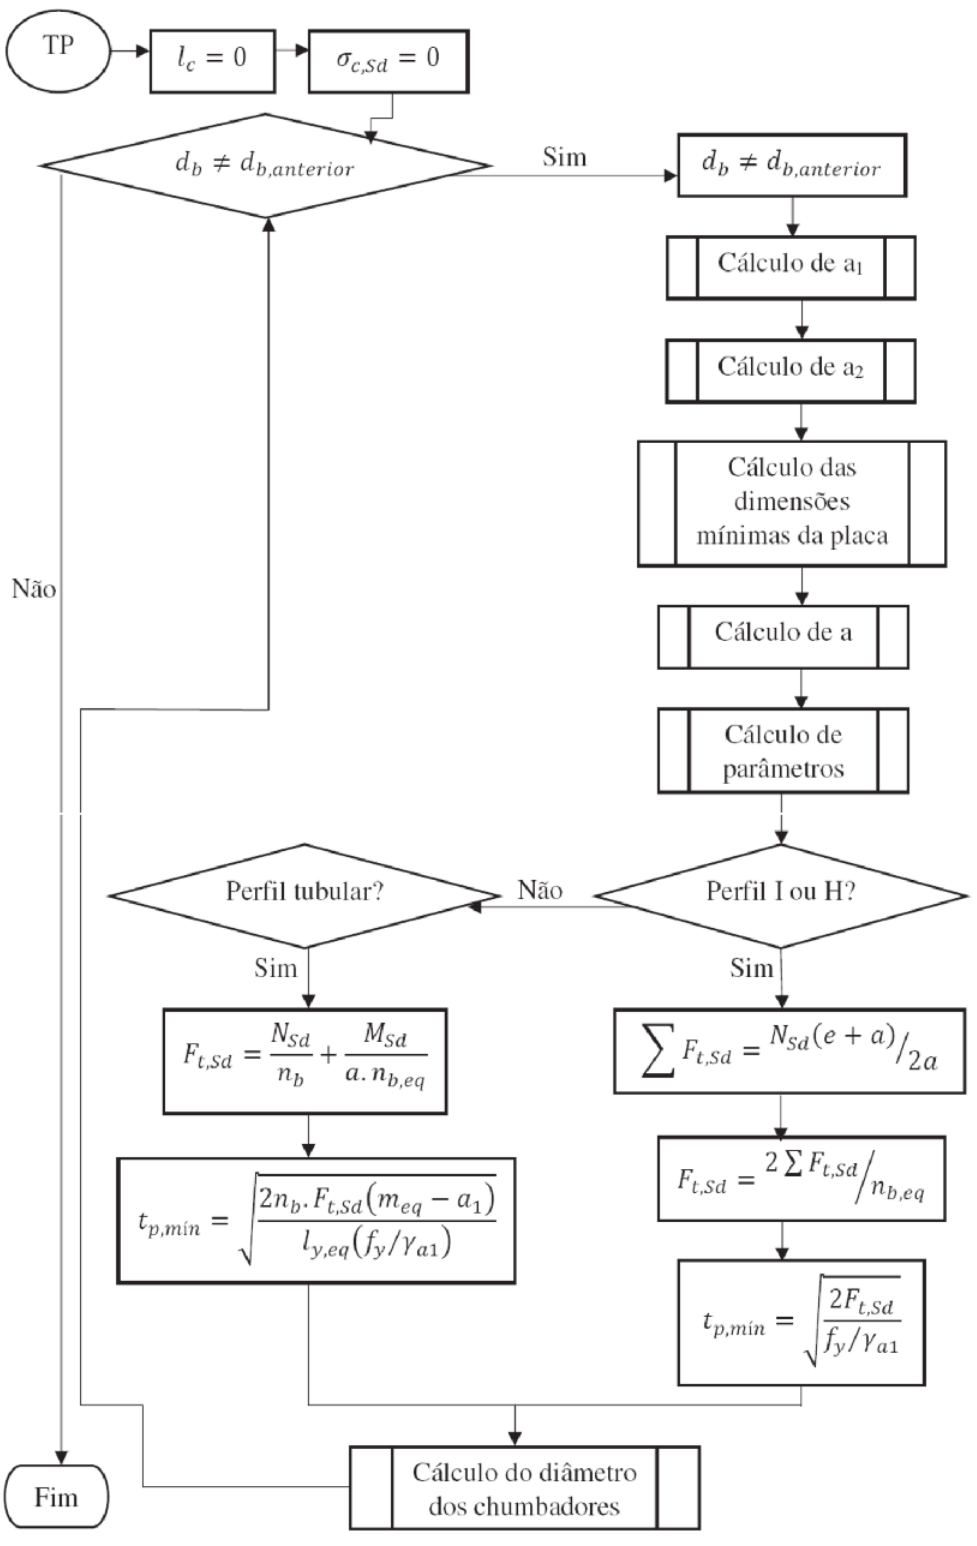
Fluxograma de bases tracionadas com pequeno